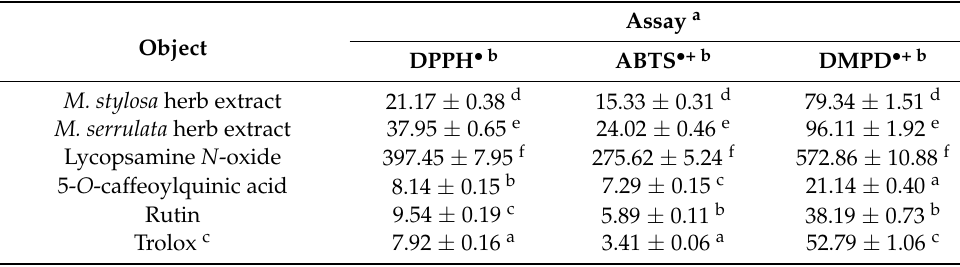
Table 4. Antioxidant activity of M. stylosa , M. serrulata herb extracts and selected compounds in three in vitro